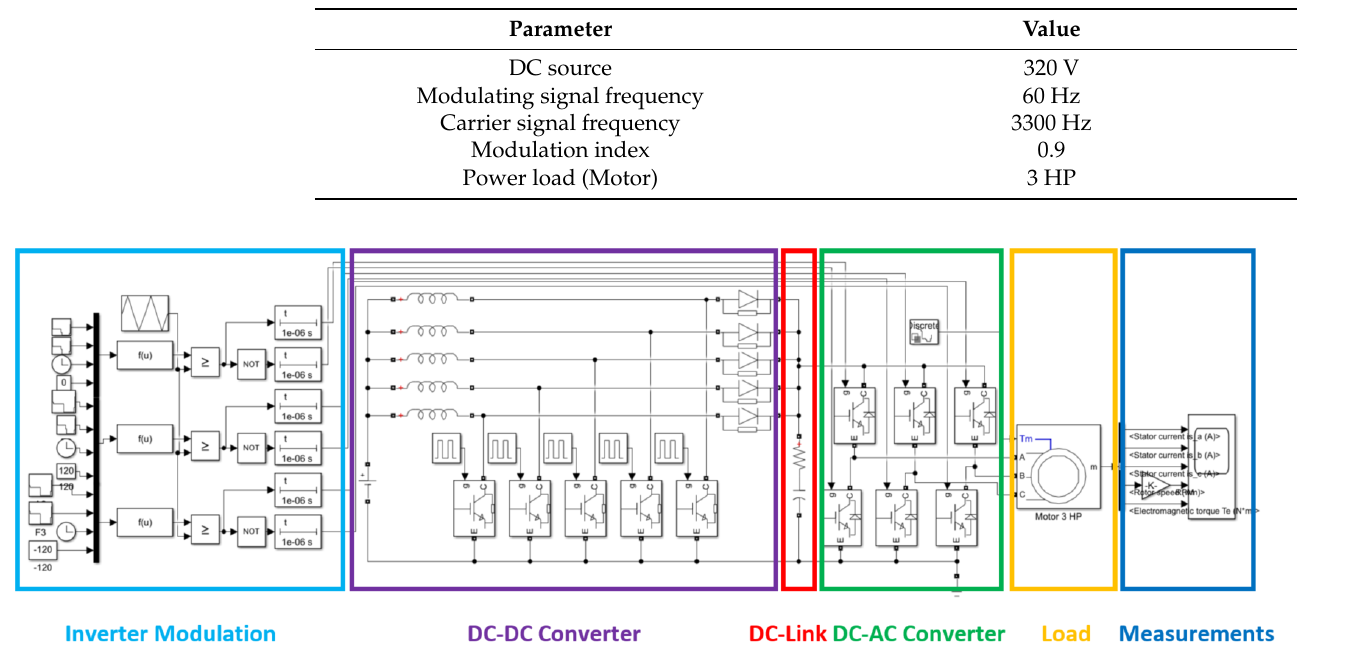
Table 4. Design specifications used.